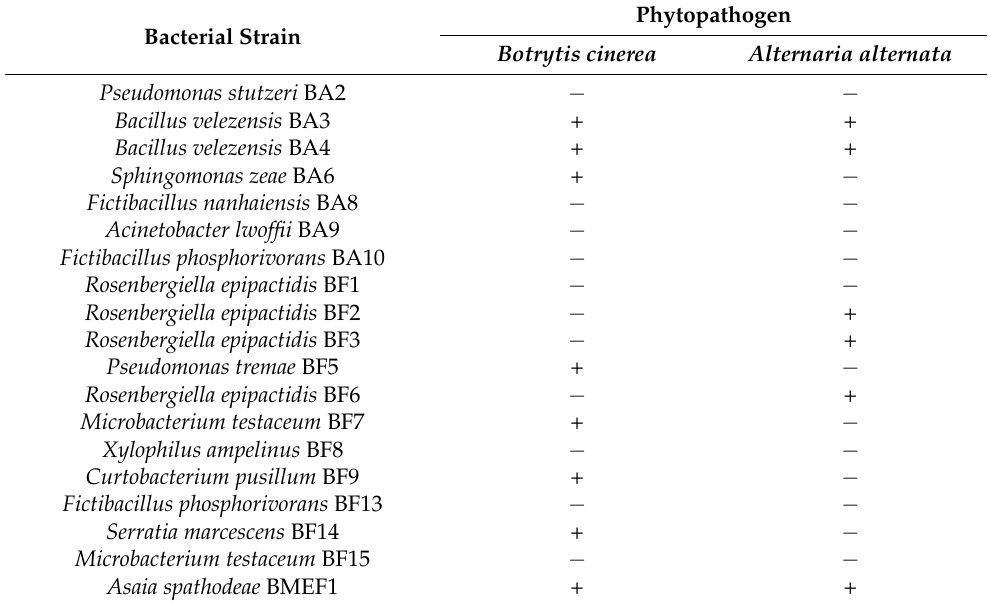
Table 2. In vitro preliminary screening of bacterial isolates obtained by the dual culture assay with B. cinerea and A. alternata as the test